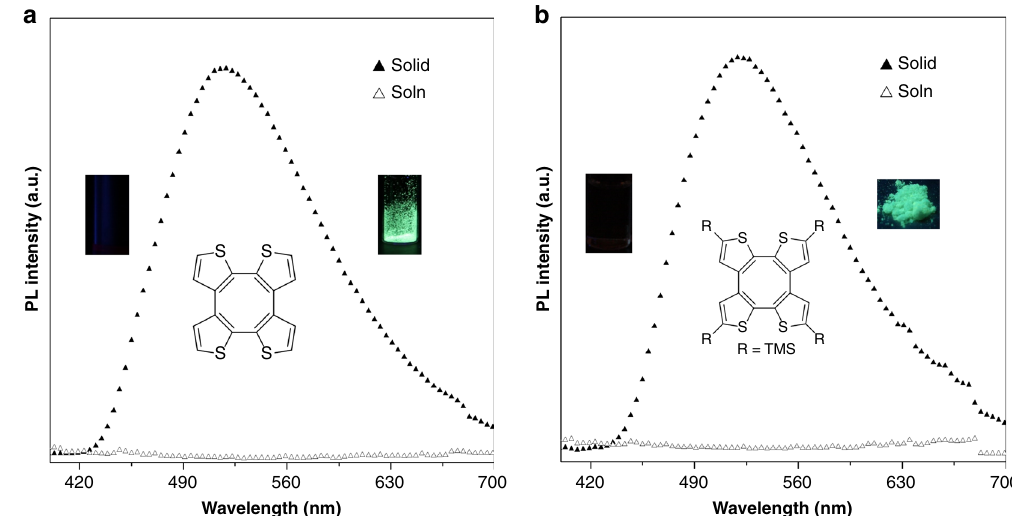
Fig. 3 Photophysical properties. a The emission of THF solution (empty triangles) and solid (full triangles) of COTh, concentration: 10 μ M, excitation wavelength is 350 nm. Inset: the fl uorescence pictures of THF solution (left, dark) and solid (right, green fl uorescence) of COTh taken under an excitation wavelength of 365 nm by a portable UV lamp. b The emission of THF solution (empty triangles) and solid (full triangles) of COTh-TMS, concentration: 10 μ M, excitation wavelength is 350 nm. Inset: the fl uorescence pictures of THF solution (left, dark) and solid (right, green fl uorescence) of COTh-TMS taken under an excitation wavelength of 365 nm by a portable UV lamp